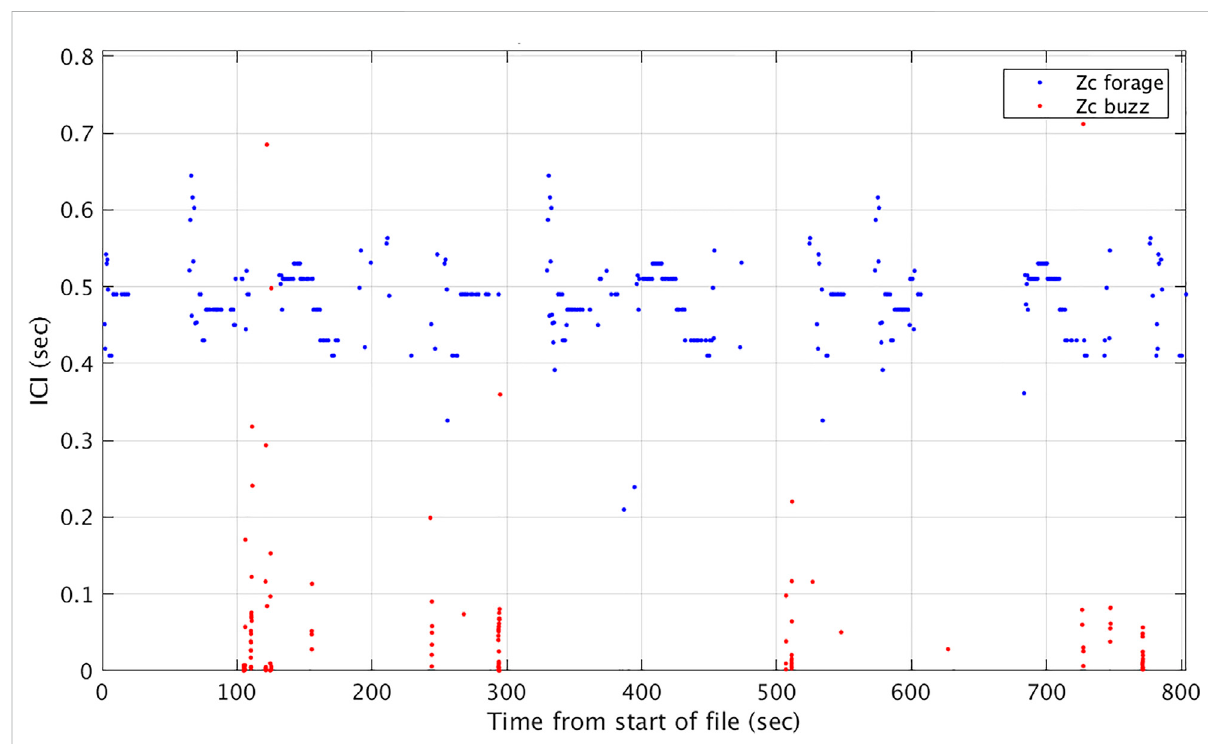
FIGURE 6 ICI calculated from CS-SVM Zc foraging click detection reports and CS-SVM buzz click detection reports from SOAR hydrophone 609 versus time. Abrupt changes in ICI highlight the